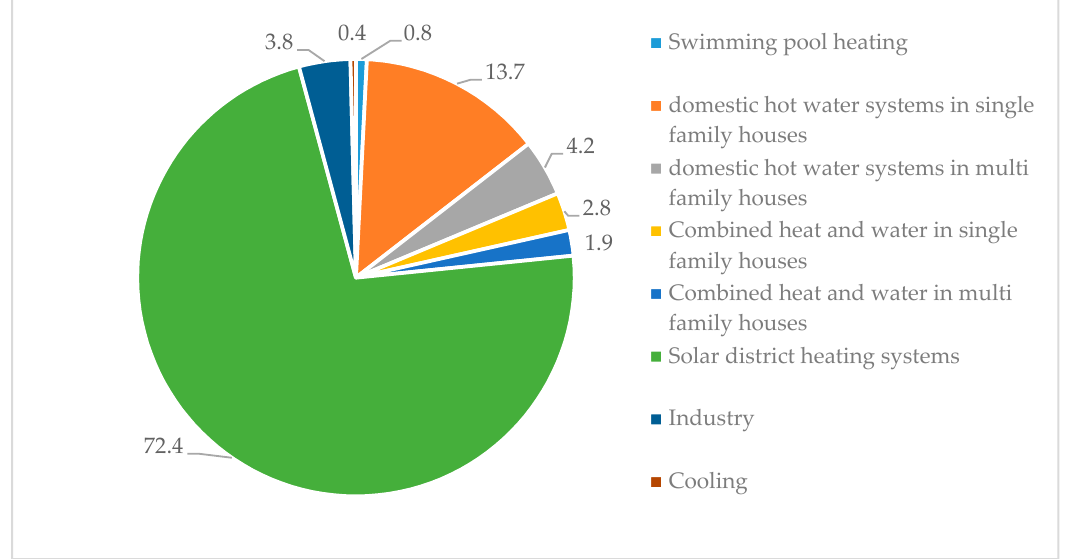
Figure 10. Distribution of solar collectors in Russia by application [11].